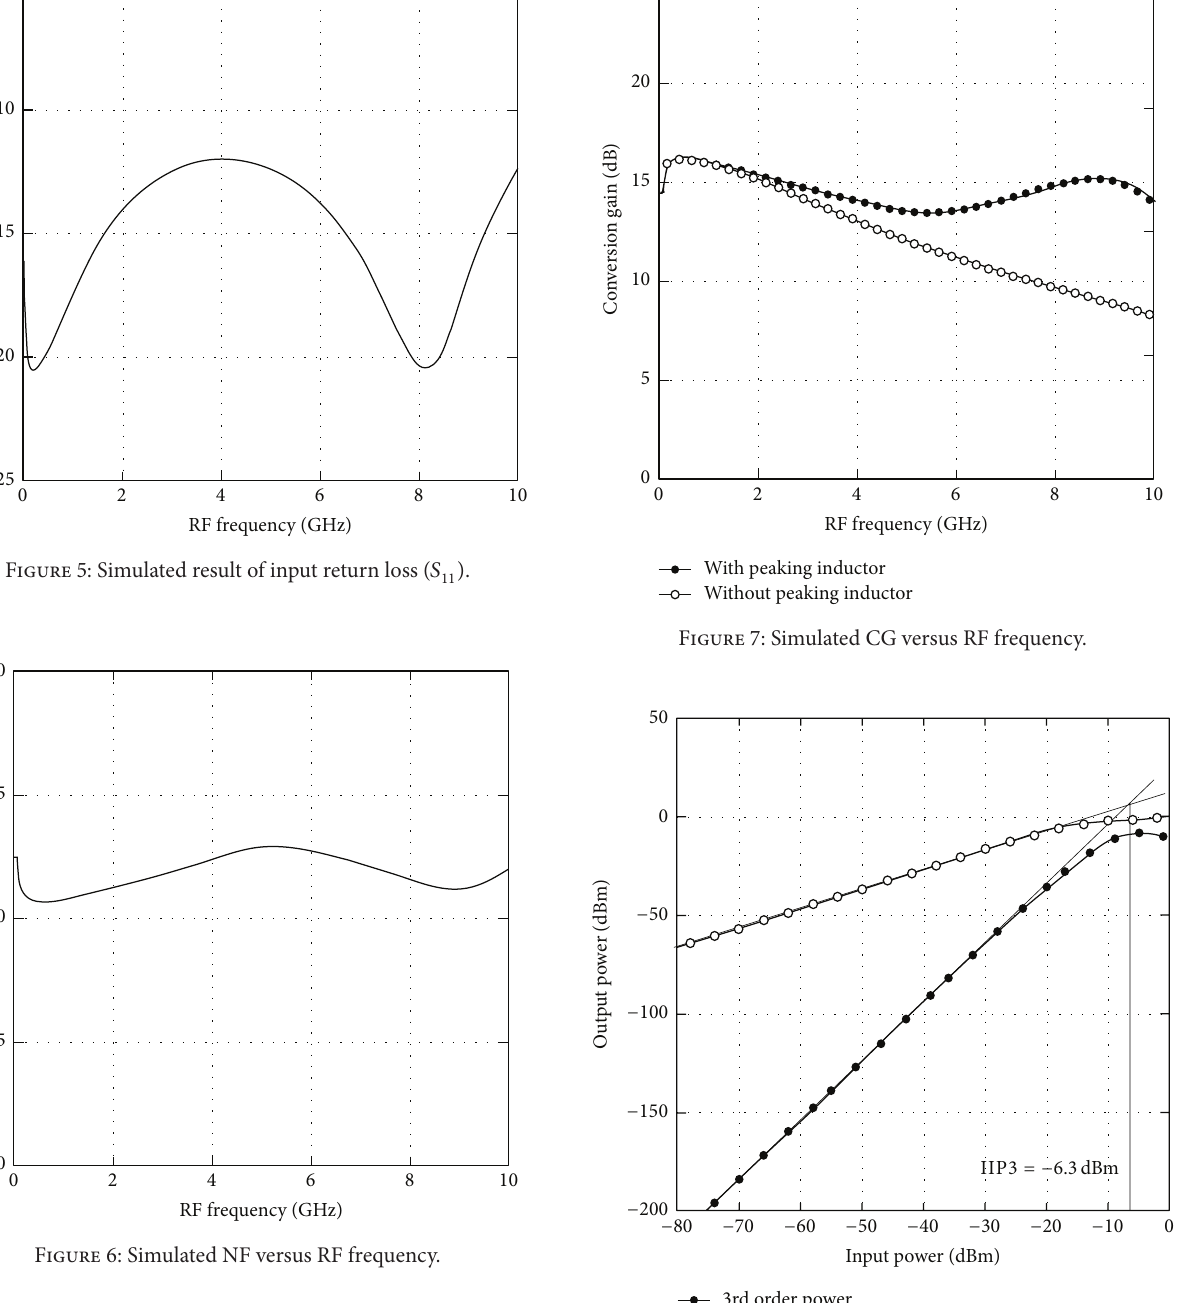
achieves a P1dB range of − 17.0 dBm to − 13.6 dBm while the IIP3 ranges from − 8.1 dBm to − 4.5